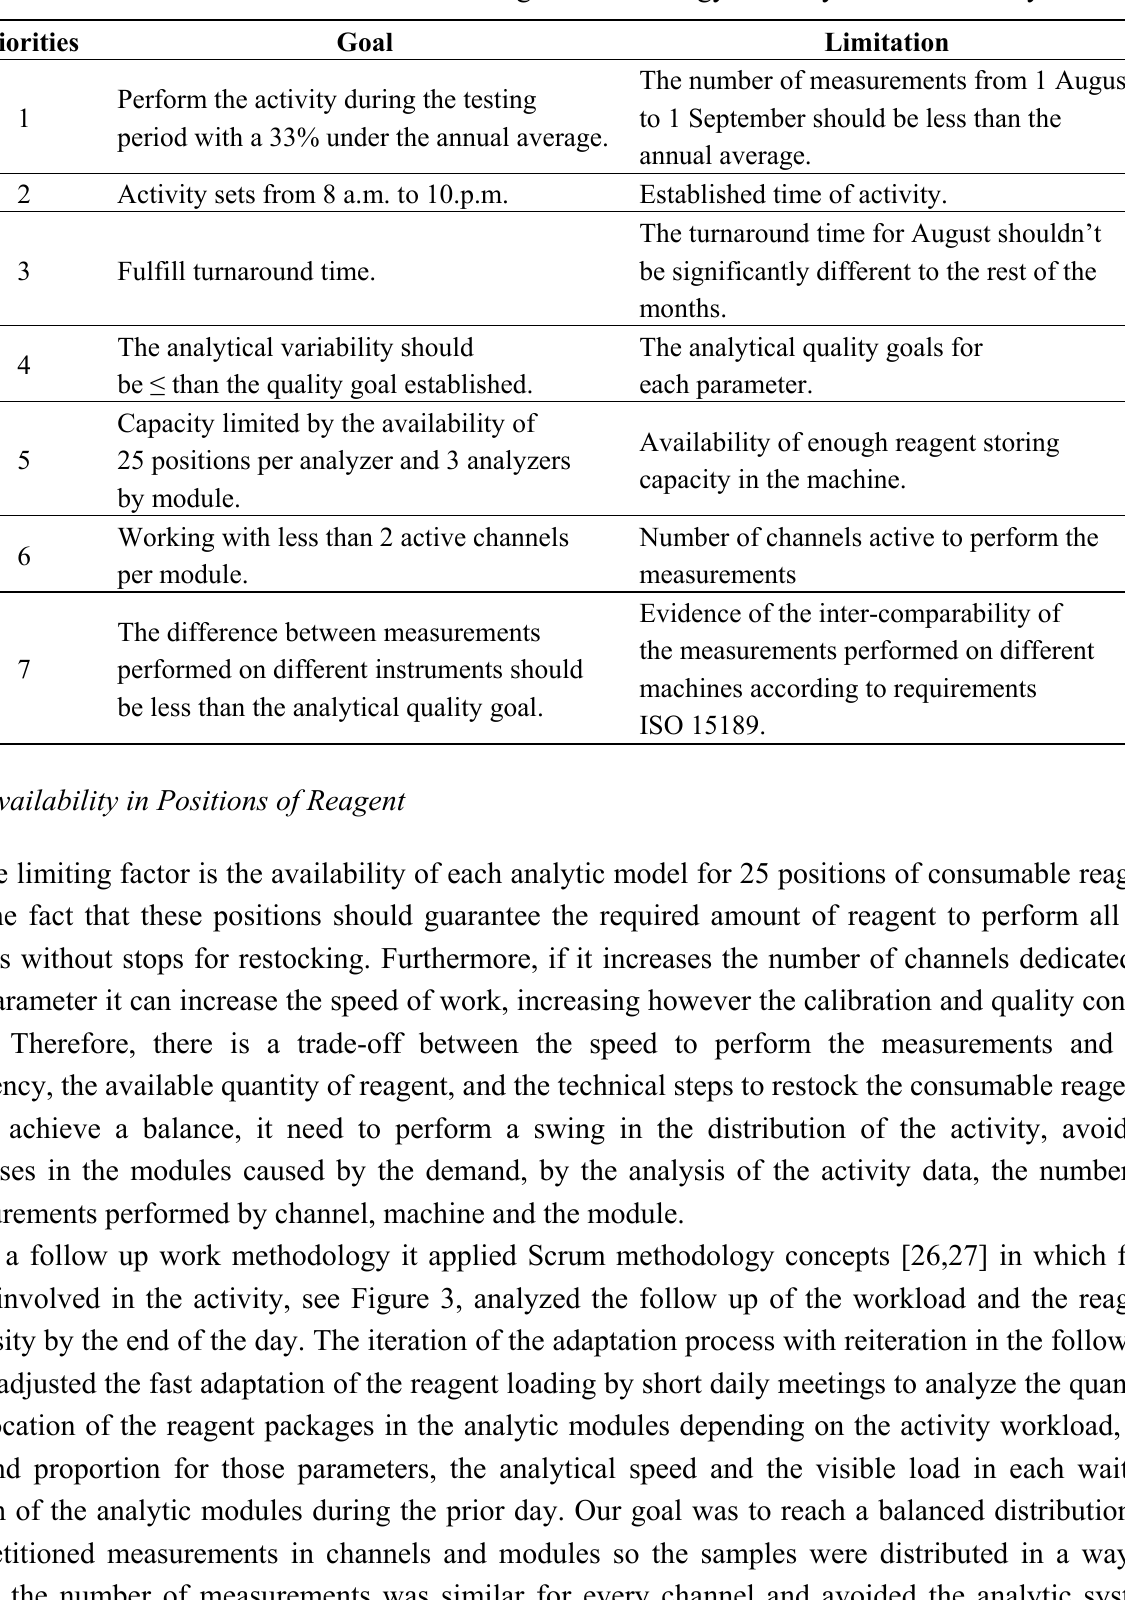
Table 2. Goals and limitations of the Agile methodology in the system under